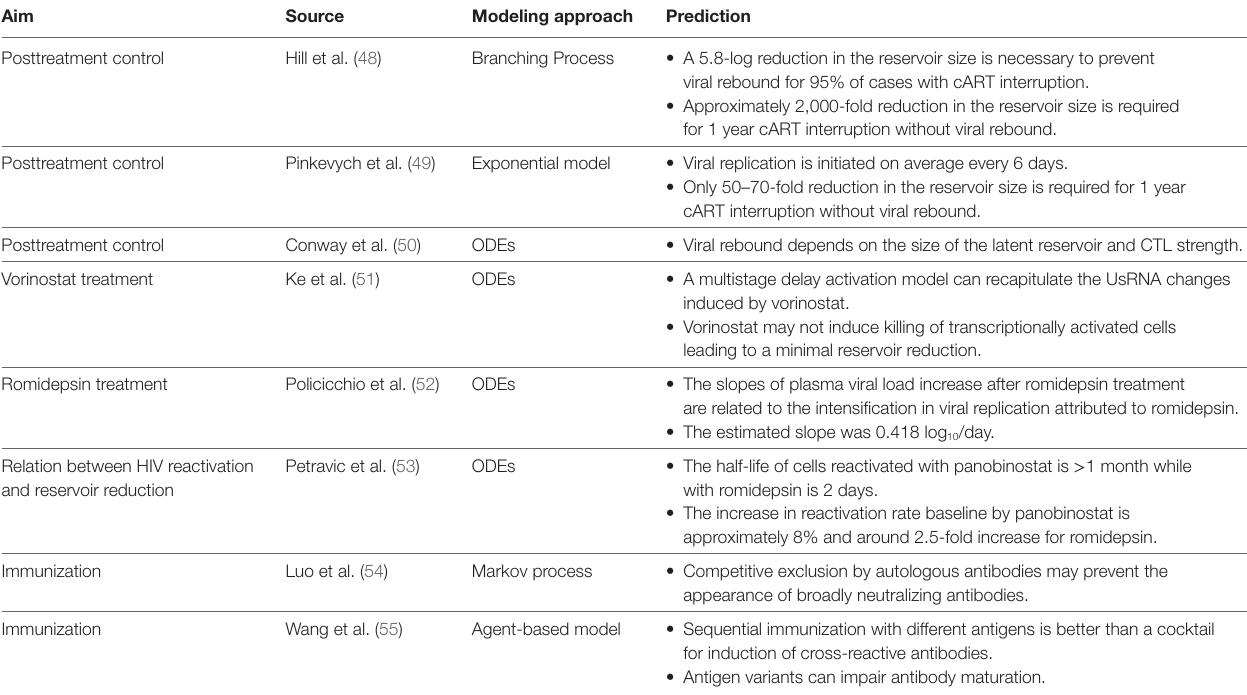
TAbLe 1 | Mathematical models discussing an HIV